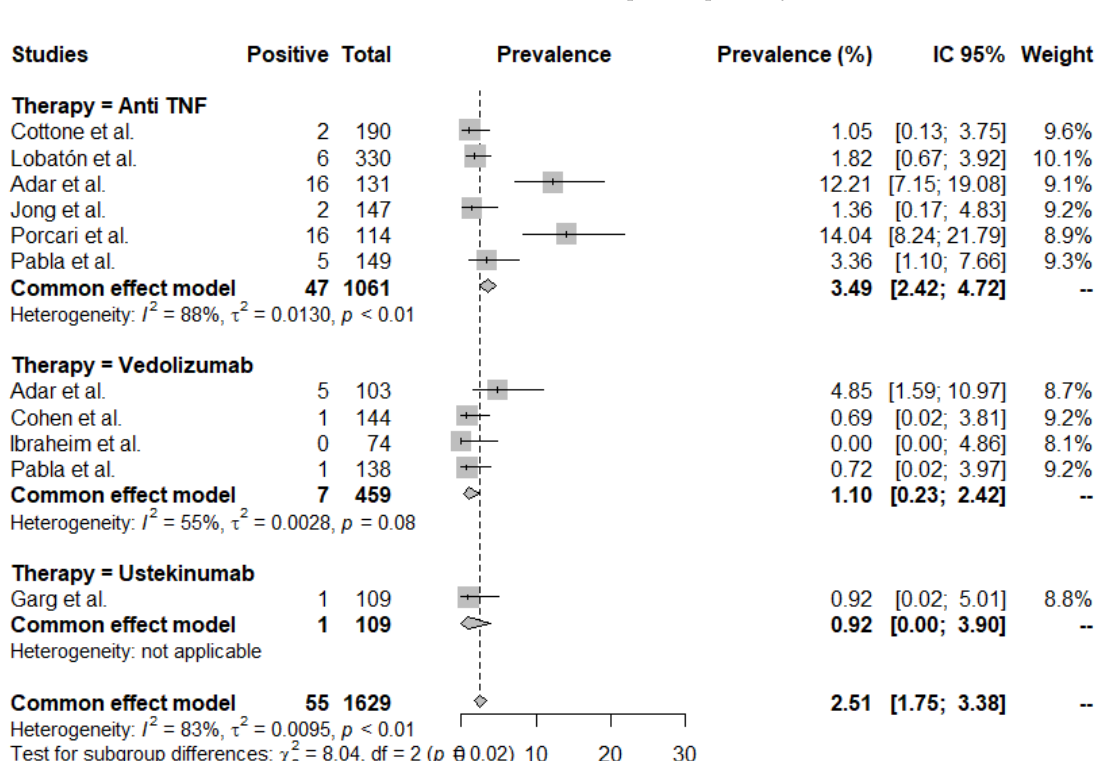
Figure 4. Rates of infusion/injection reaction. Mean rates per 100 patient years (PY).